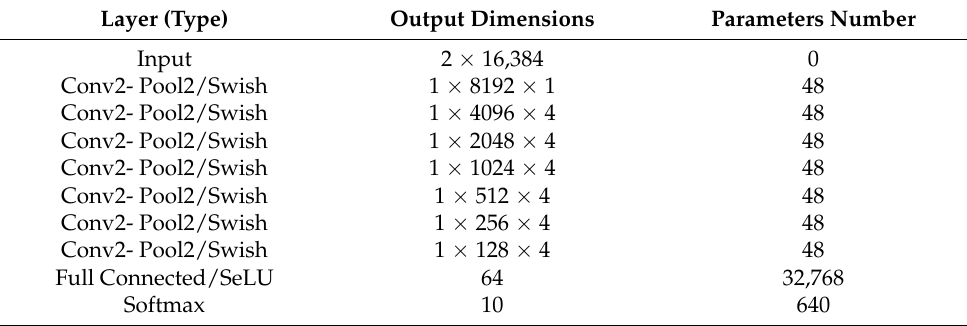
Table 2. CNN structure and the simulation